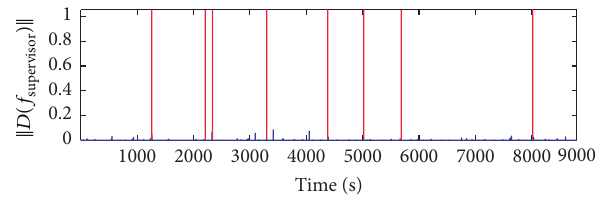
)‖ along the sequence of Figure 16: Evolution of ‖𝐷(𝑓 supervisor missions. Values larger than 1 mean that the mission was not successfullycompleted.Graphicisboundedtoapproximately1.1,but )‖ is much higher. for failed missions ‖𝐷(𝑓 supervisor